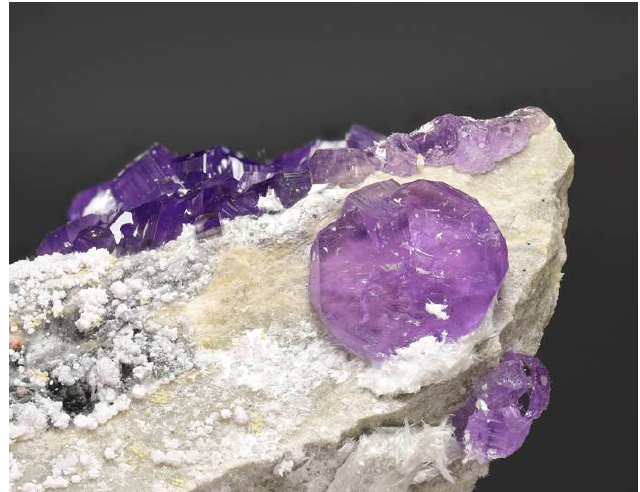
Figure 8. Coquimbite from the Monte Arsiccio mine, as purple pseudohexagonal prismatic crystals, up to 1.5 cm across.